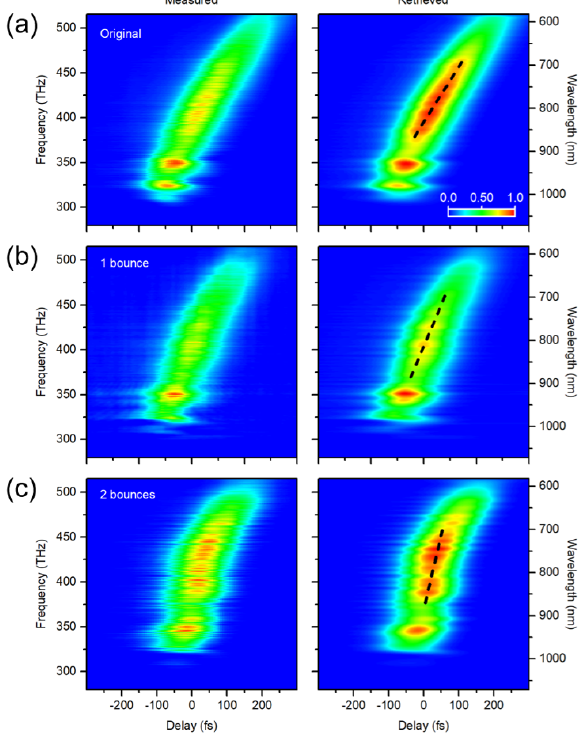
Figure 13. Trace plots of PG-FROG measurements: ( a ) properties of original pulse, ( b ) properties of